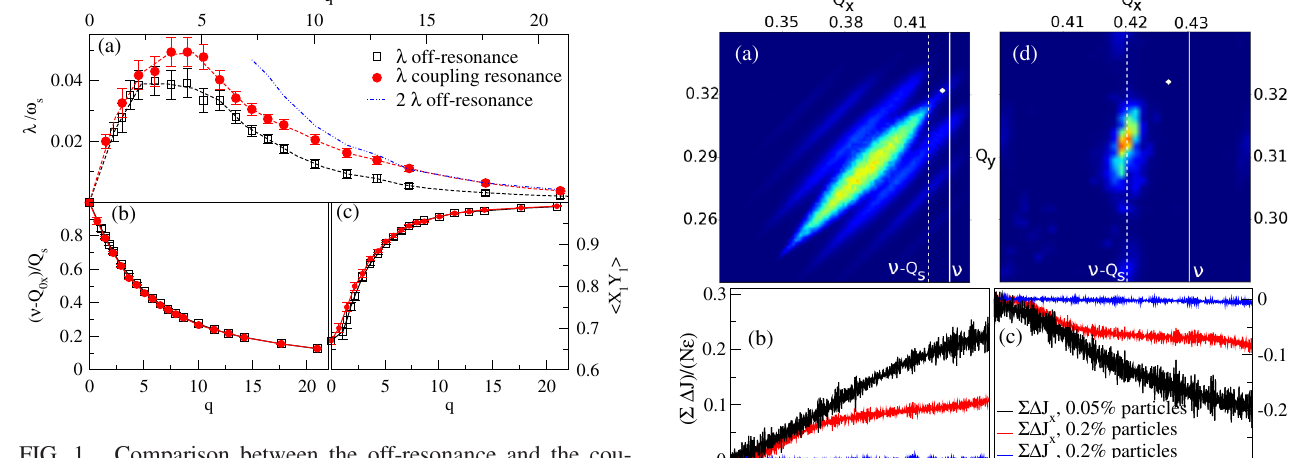
FIG. 1. Comparison between the off-resonance and the cou- pling resonance cases for the first space charge mode: (a) Landau damping rate λ versus space charge parameter q , where ω ω s ω 0 Q s is the synchrotron frequency. For intermediate and strong space charge the damping is larger at the coupling resonance. (b) The mode tune ν at off-resonance and at coupling resonance are nearly the same. (c) The spatial overlap, Eq. (15), of the DMD extracted mode X 1 ð z; u Þ with the space charge harmonic function Y 1 ð z Þ . The off-resonance and the coupling resonance mode shapes are nearly the